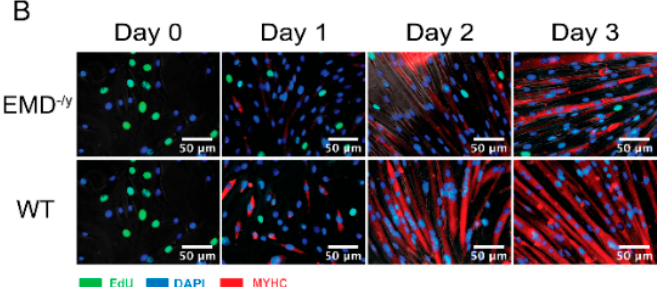
Figure 1. H2K myogenic progenitors have impaired differentiation and delayed cell cycle exit. A,